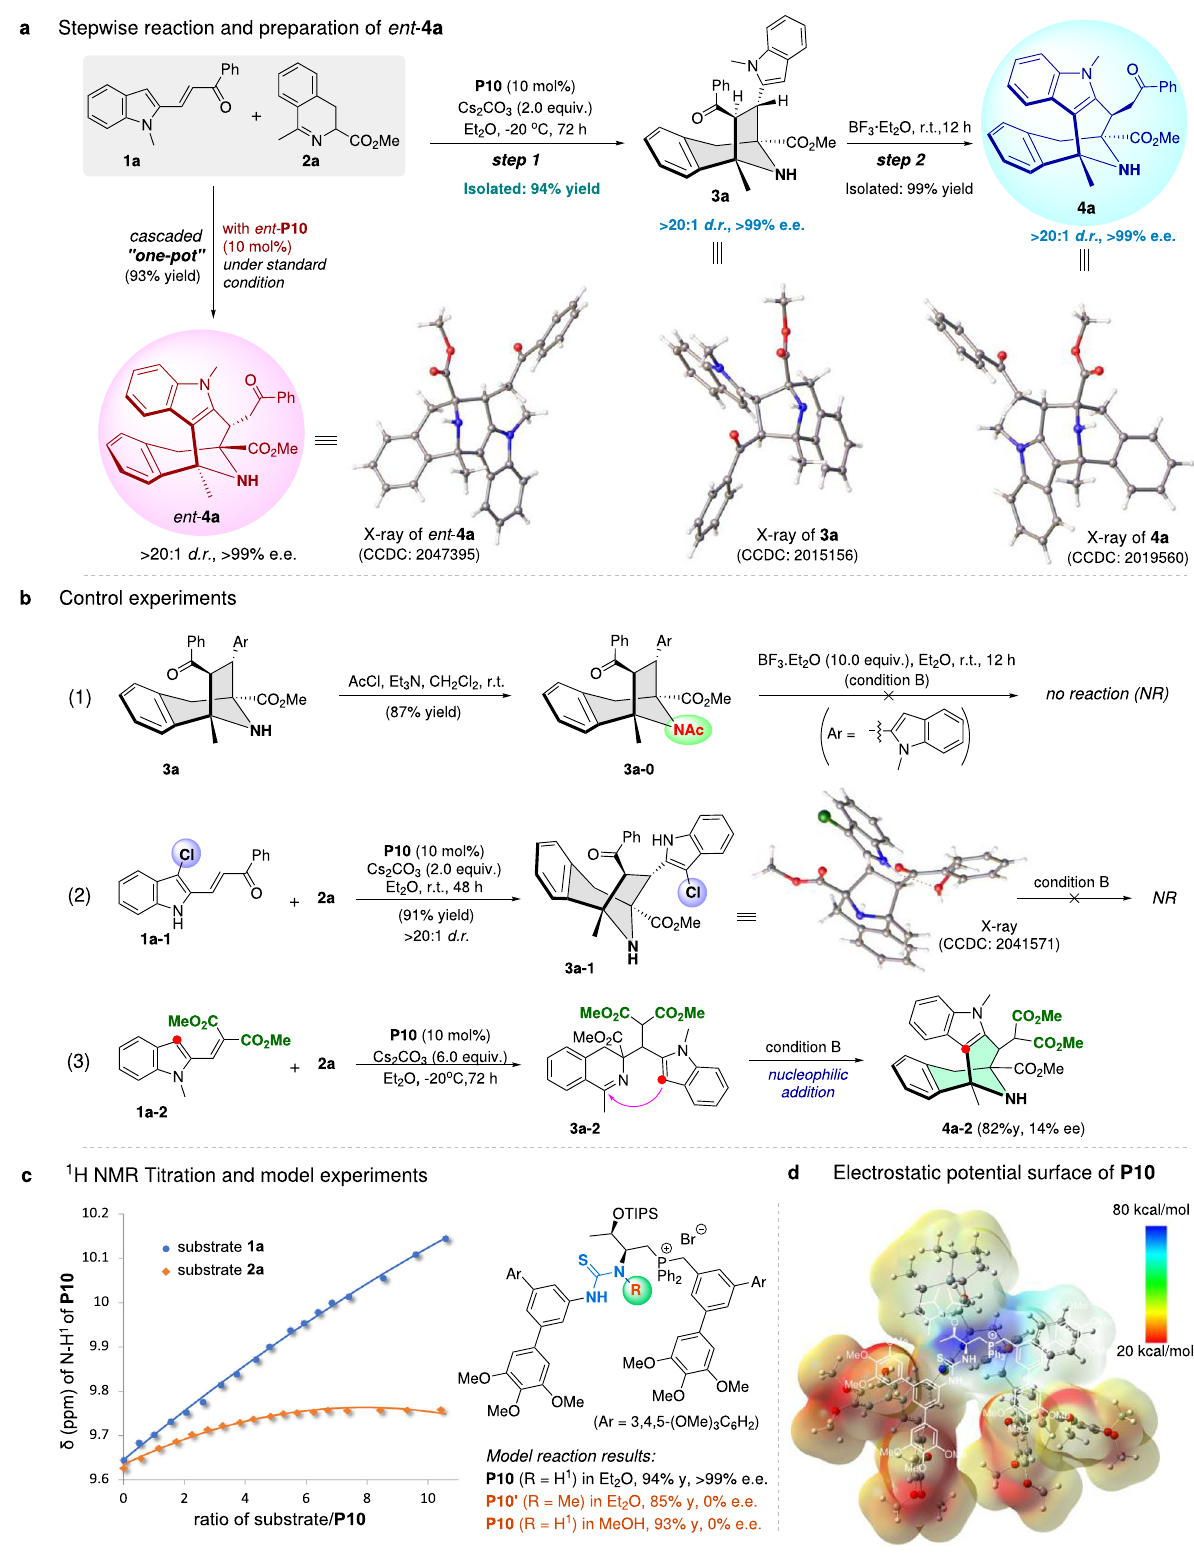
Fig. 7 Mechanistic investigations. a Stepwise reaction and preparation of ent - 4a . b. Control experiments. c 1 H NMR titration and model experiments(sample size, n = 18). d Electrostatic potential surface (ESP) of catalyst P10 .